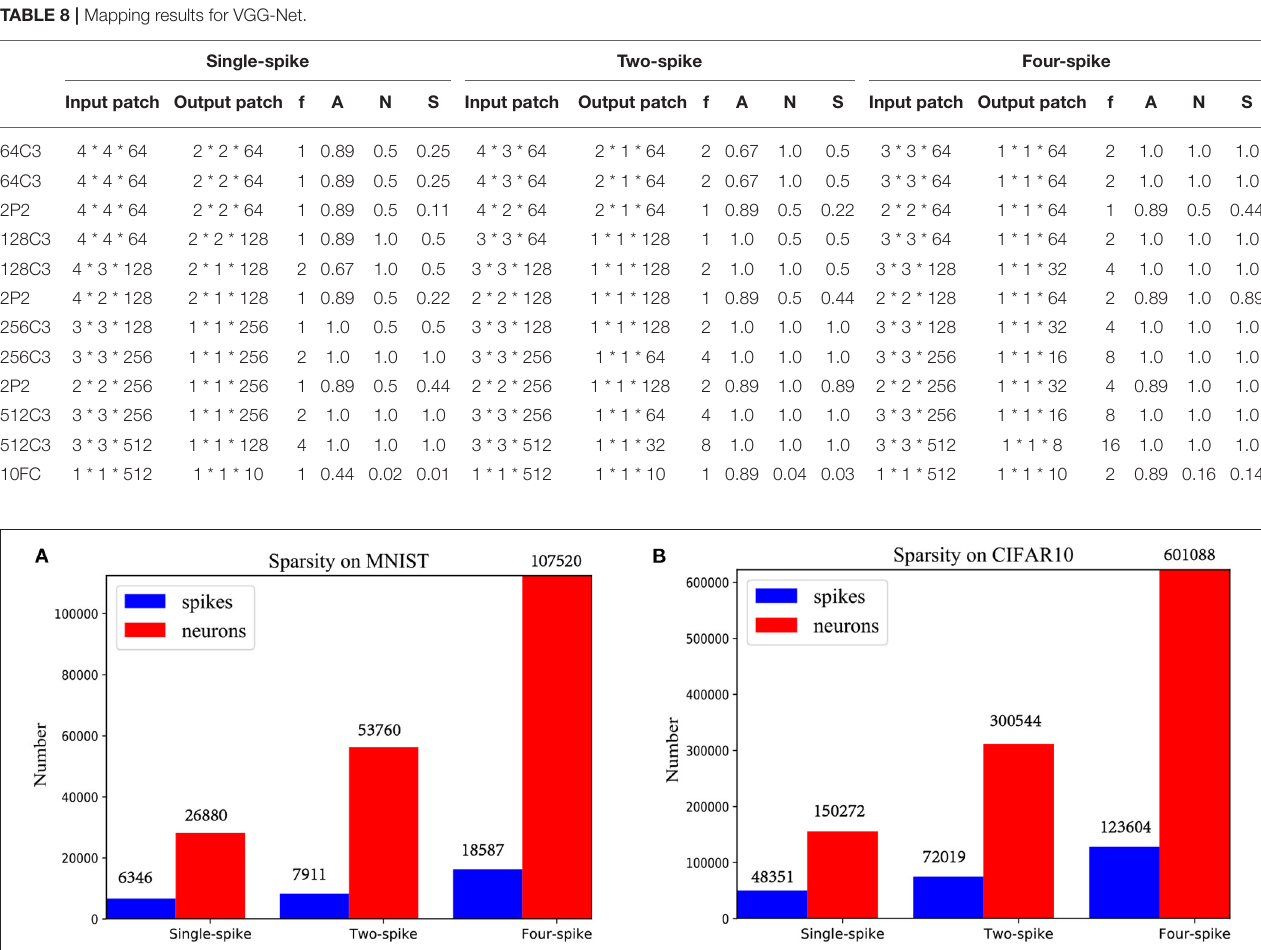
TABLE 8 | Mapping results for VGG-Net.